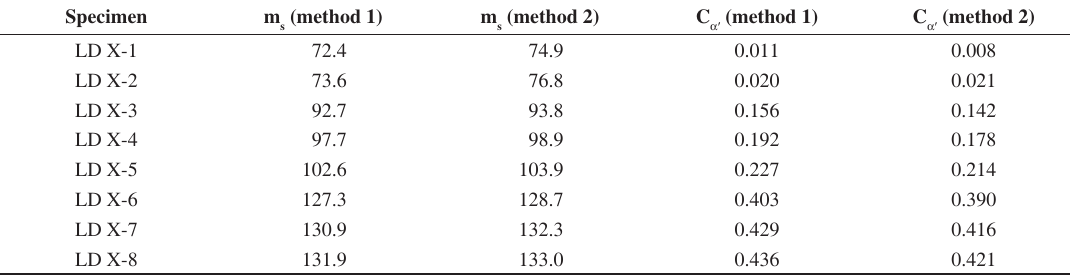
Table 4. Martensite volume fractions determined by magnetic methods 1 and 2.